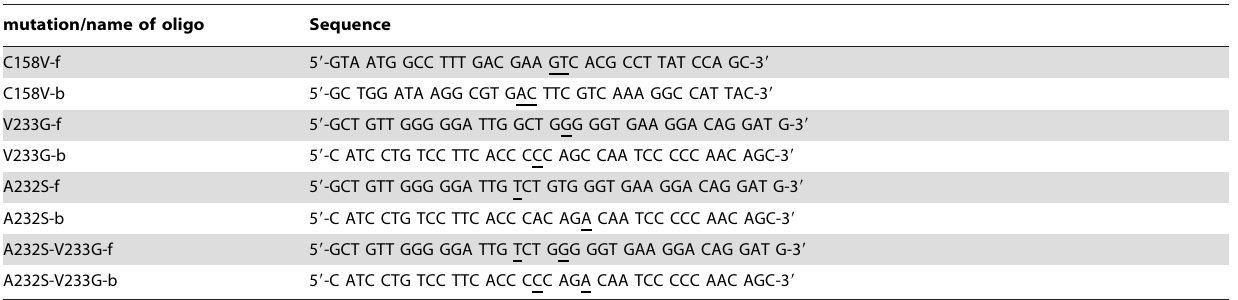
Table 5. Oligonucleotides used in mutagenesis.